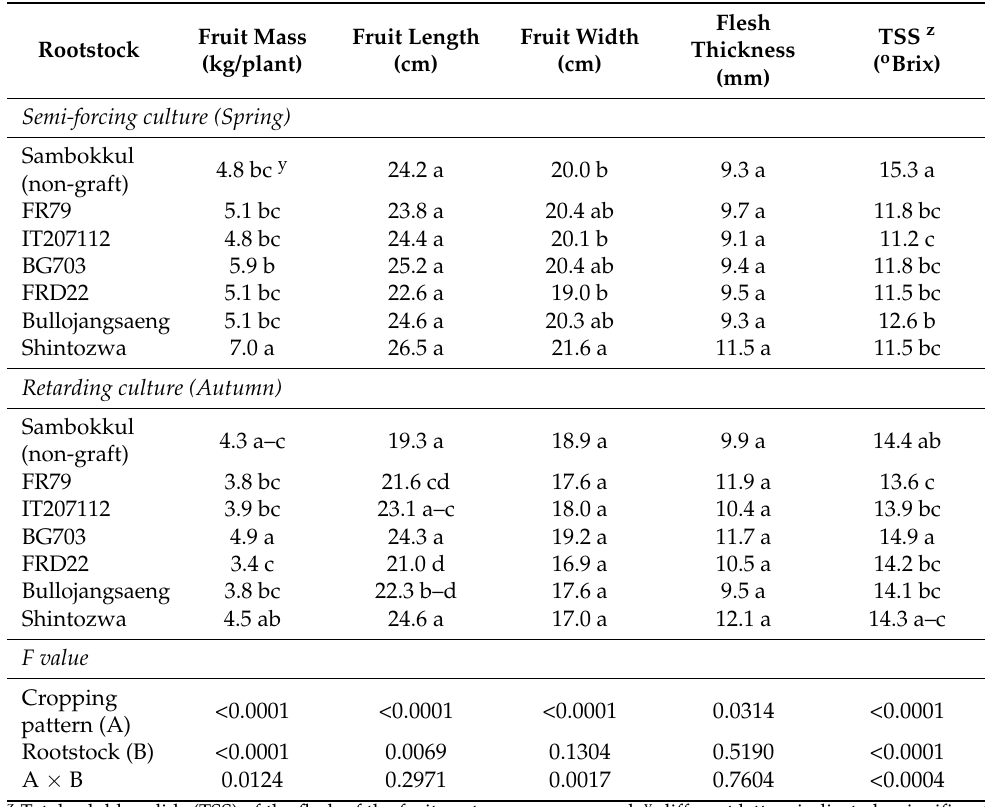
Table 4. Fruit mass, fruit length and width, flesh thickness, and total soluble solids (TSS) of water- melon influenced by bottle gourd rootstocks.